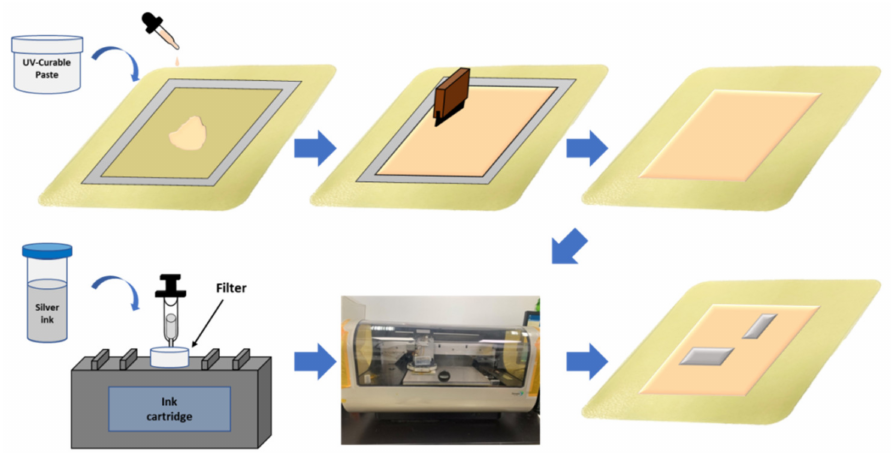
Figure 3. Schematic diagram of the inkjet printing process of silver film onto a hydrocolloid thin wound